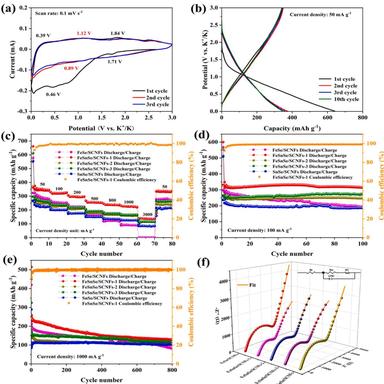
(a) Cyclic voltammetry curves of FeSnSe/SCNFs-1; (b) Charge/discharge curves of FeSnSe/SCNFs-1 at 50 mA g− 1 ; FeSe/SCNFs, FeSnSe/SCNFs-1, FeSnSe/ SCNFs-2, FeSnSe/SCNFs-3 and SnSe/SCNFs (c) multiplicity performance at 50 mA g− 1 to 3000 mA g− 1 ; (d) cycling performance at 100 mA g− 1 ; (e) cycling performance at 1000 mA g− 1 ; (f) EIS Nyquist plot.